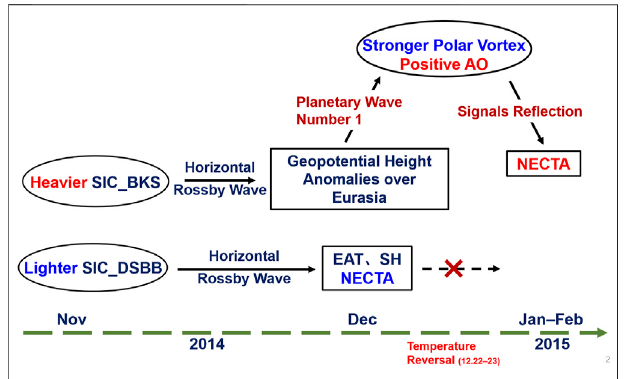
FIGURE 10 | Illustration of the factors and physical mechanisms related to the temperature reversal over NEC in winter 2014/2015.